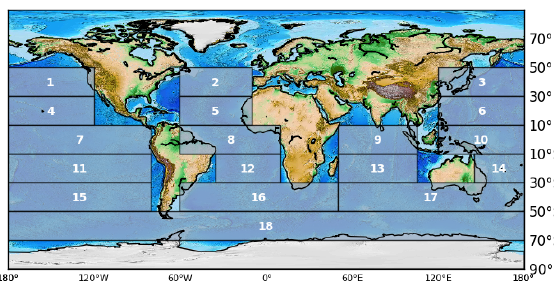
Figure 3. Large-scale areas where temperature and salinity spatial correlations were calculated.